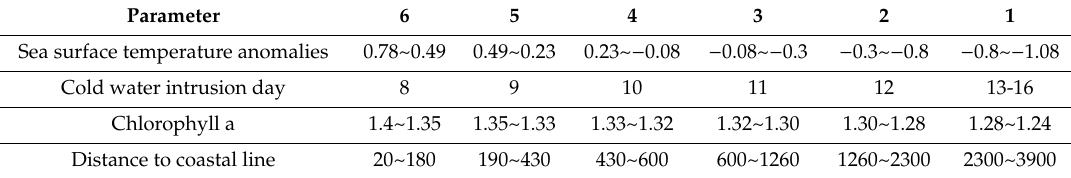
Figure 3. ( a ) Histogram of high-speed wind days (>6 m/s) during the wintertime (January and February) from 2002 to 2015 in the Penghu Islands. ( b ) The injury areas during the extreme events of cold disaster (2008 and 2011) of 49 grids. Table 1. The standard of variable influence scores of the four parameters used in this study.